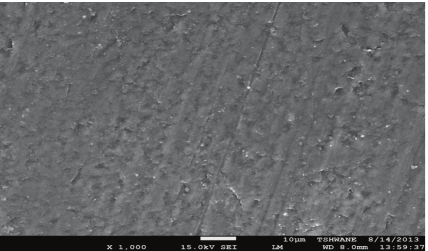
Figure 18: SEM micrograph of neat epoxy resin after fabrication.